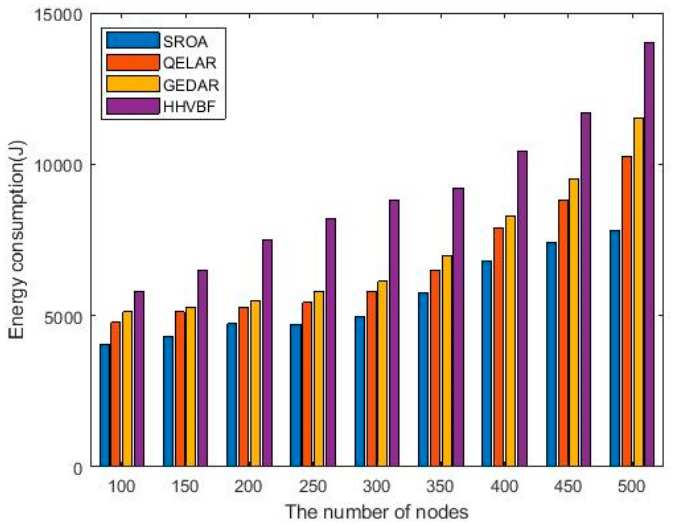
Figure 12. Comparison of energy consumption for the four protocols.